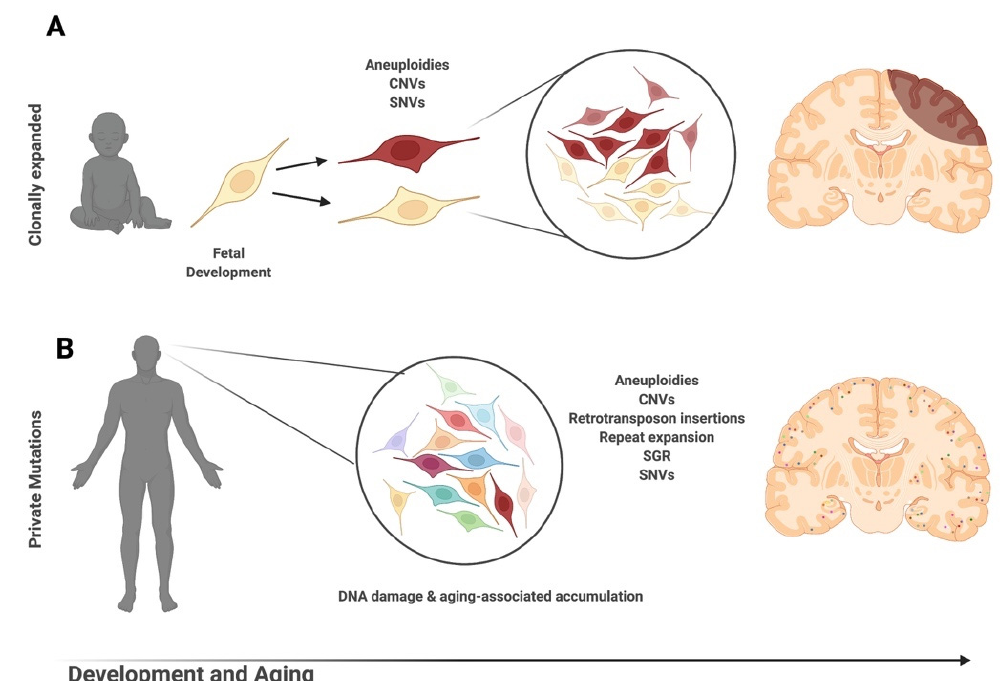
Figure 2. Clonal versus private somatic mutations in the human brain. ( A ) Somatic mutations that occur at different timepoints within embryogenesis or neurogenesis will result in clonal mutations shared by the brain and other body tissues or between brain cells of a single lineage. Clonal somatic aneuploidies, copy number variations (CNVs), and single-nucleotide variations (SNVs) have been described between the brain and peripheral lymphocytes (occurring early in embryogenesis), between the brain and other ectodermal-derived tissues (occurring after trilaminar disc formation), and between separate brain regions (occurring during neurogenesis). ( B ) Private or unique somatic mutations are unique to a single neural cell and accumulate throughout one’s lifespan. These somatic events may be independent of replication, as evidenced by their presence in post-mitotic cells. Aneuploidies, CNVs, retrotransposon insertions, repeat expansions, somatic gene recombination (SGR), and SNVs have all been described as occurring in post-mitotic neurons.